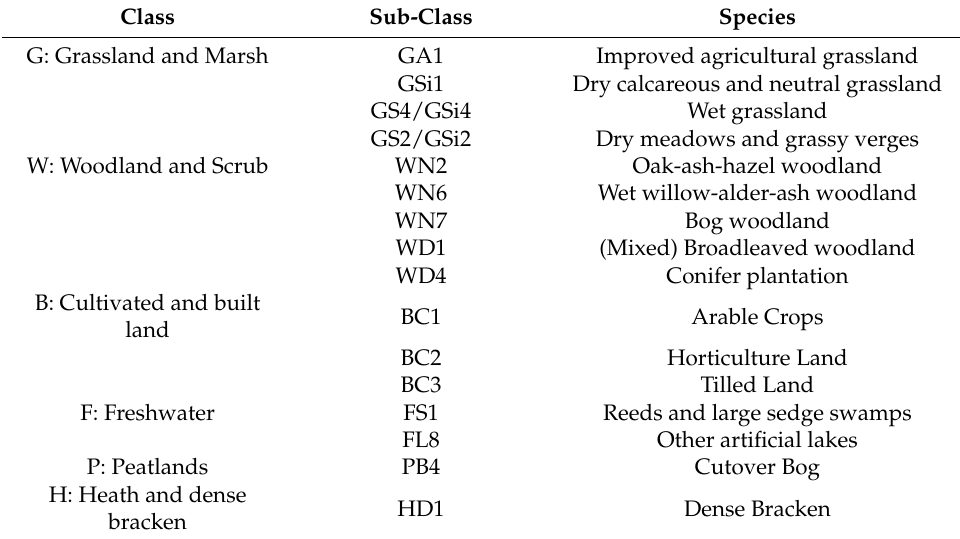
Table 1. Habitat Types of the Image